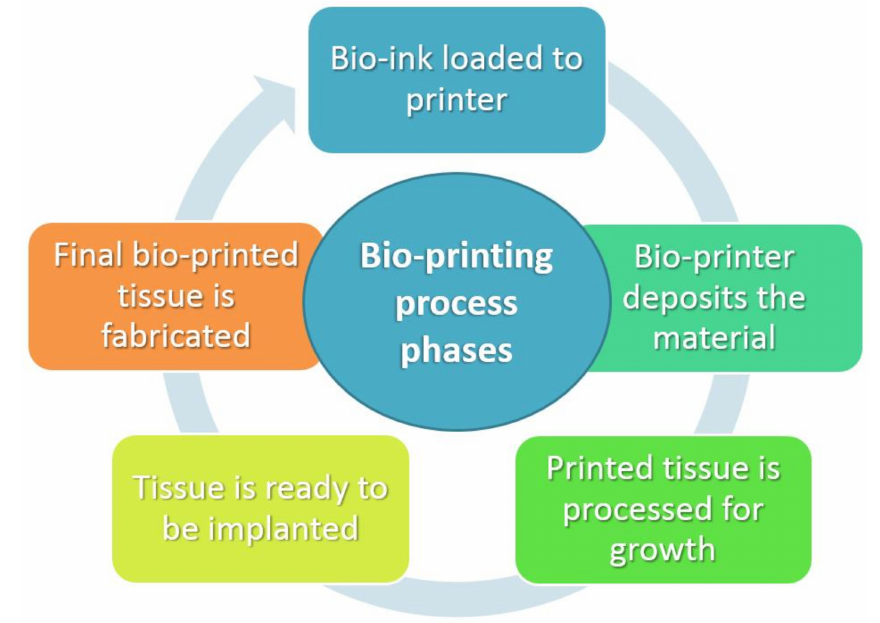
Figure 1. Distinct stages of bio-printing process. Table 1. Raw materials used in bio-printing